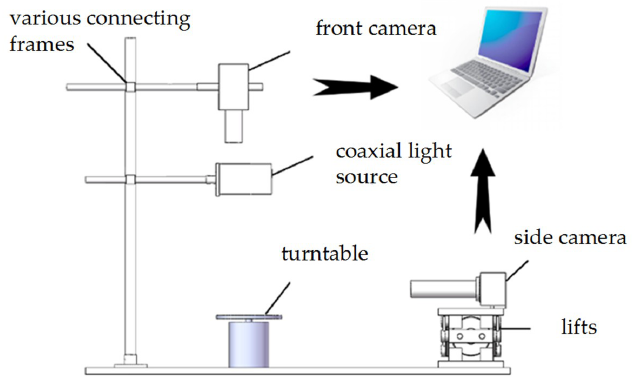
Figure 4. Schematic diagram of experimental equipment.